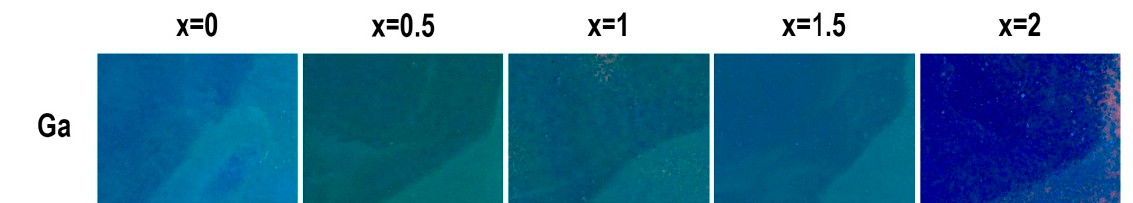
Figure 5. Digital photographs of the ceramic glazes prepared with Ga-doped pigments.